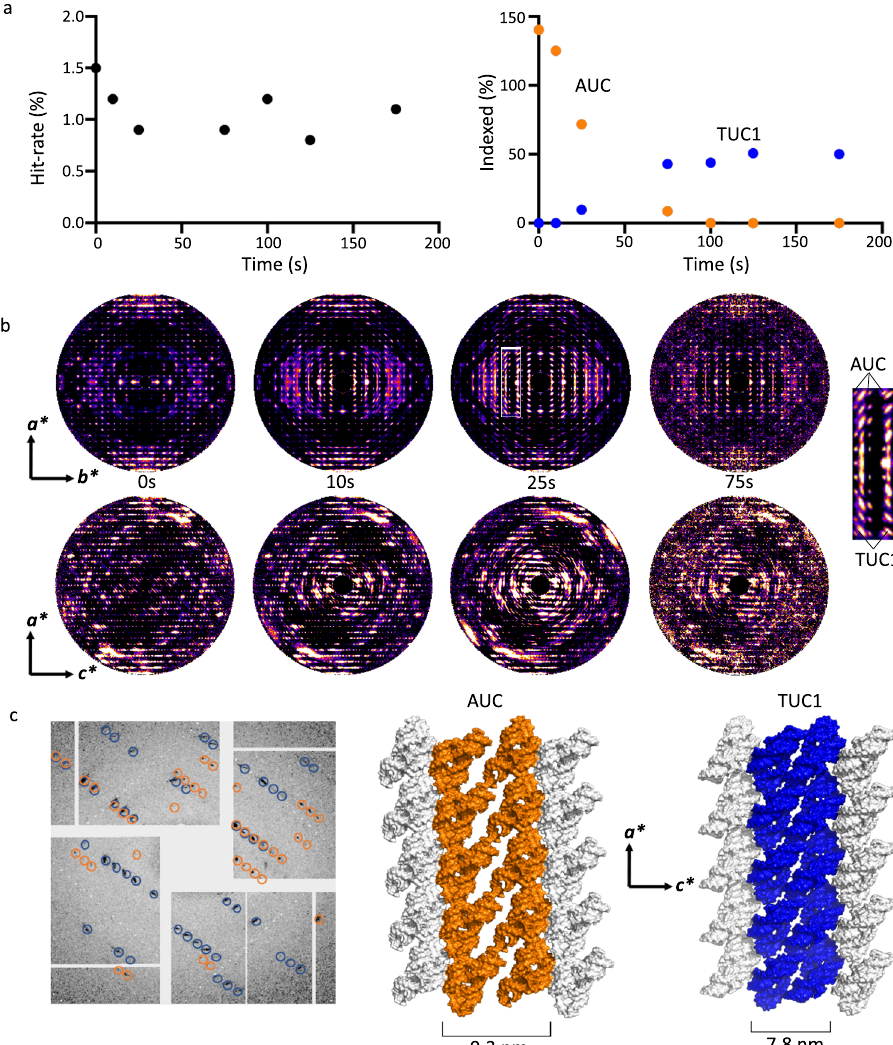
Fig. 3 Phase transition observed by time-resolved serial crystallography. a Plots of X-ray diffraction hit-rate (left) and indexing rate (right) for AUC (orange) and TUC1 (blue) lattices as a function of delay time after mixing 1:1 with 20 mM ADE. For the non-mixed sample (0 s), the average ratio of sample:buffer was 2:1, yielding a slightly higher hit-rate. The AUC to TUC1 conversion occurs much earlier than that observed in PVM and AFM experiments, where lower ligand concentrations (1 mM for PVM, and 50 or 150 µ M for AFM) were used due to the requirements of those experiments. b Cross-sections ( a*b* , a*c* ) of the 3D-merged reciprocal lattices of AUC-indexed crystals at different delay times. An expanded subsection (white box) of a*b* at 25 s shows the emergence of broad, intense Bragg peaks corresponding to the b -axis (25.3 Å ) of TUC1. c Left: single diffraction image from a single crystal with circled indexed Bragg re fl ections belonging to either AUC (orange) or TUC1 (blue). Changes in crystal packing upon conversion from AUC (middle) to TUC1 (right), resulting in a shortening of the c -axis from 9.3 to 7.9 nm and a change in the β -angle from 94.5° to